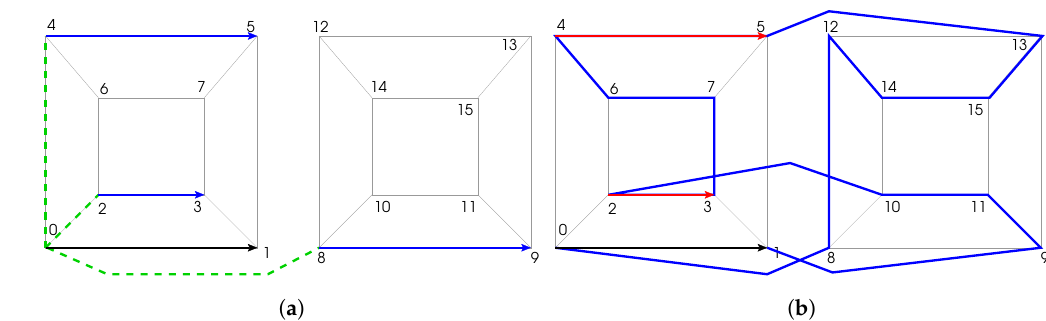
Figure 4. Examples of possible and valid parallel transitions in the 4-cube. ( a ) Possible parallel transitions (blue) for a reference transition (black); ( b ) Two valid parallel transitions (red) for the reference transition (black) in the blue